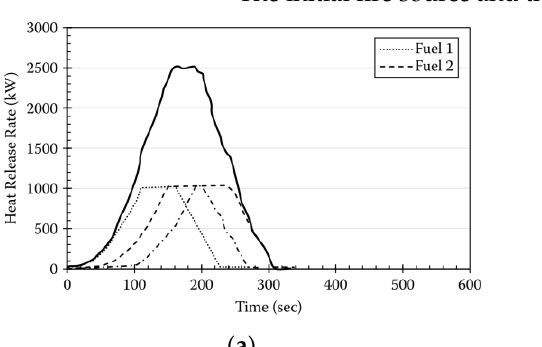
Figure 2. ( a ) Fast growth phase, narrow HRR profile characteristic. ( b ) Slow growth phase, broad HRR profile characteristic.